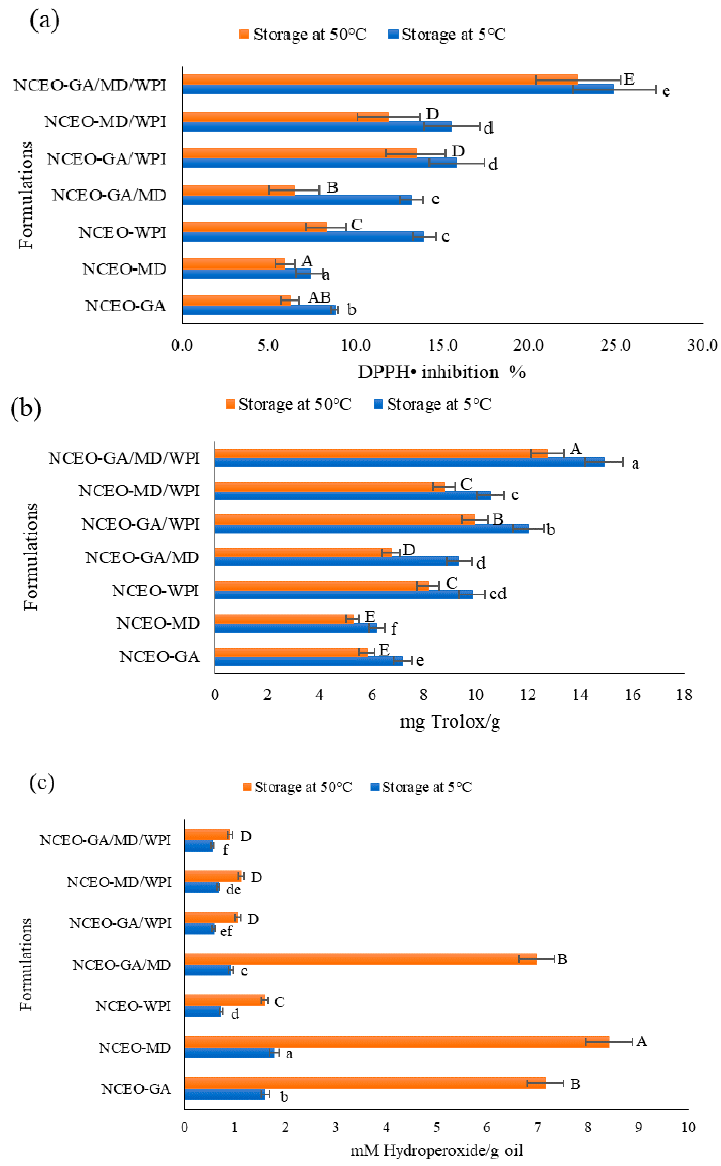
Figure 5. Antioxidant activity stability by DPPH assay ( a ), antioxidant capacity stability by ABTS assay ( b ), and oxidative stability ( c ) of CEO nanocapsules. The results are expressed as the mean ± standard deviation ( n = 3). Different lower-case letters (a–f) indicate the significant differences ( p ≤ 0.05) between the stored nanocapsules at 5 °C, and upper-case letters (A–E) indicate the significant differences between the stored nanocapsules at 50 °C.